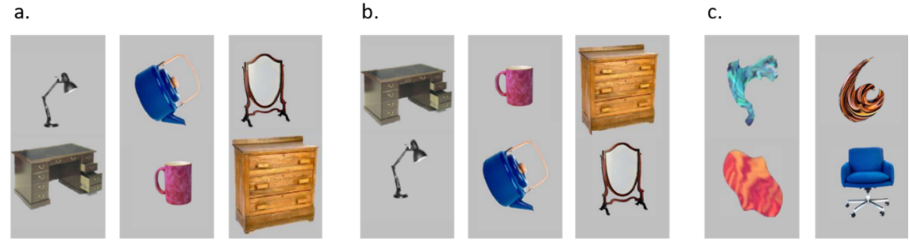
Figure 1. Examples of ( a ) spatially consistent and ( b ) spatially inconsistent pair objects. ( c ) Nonsense target shapes, paired with each other or with a real-world object.